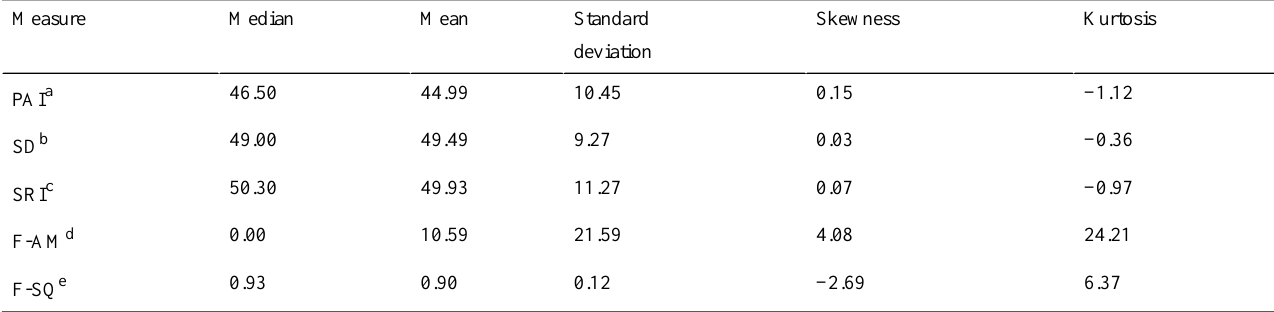
KurtosisSkewnessStandard deviationMeanMedianMeasure